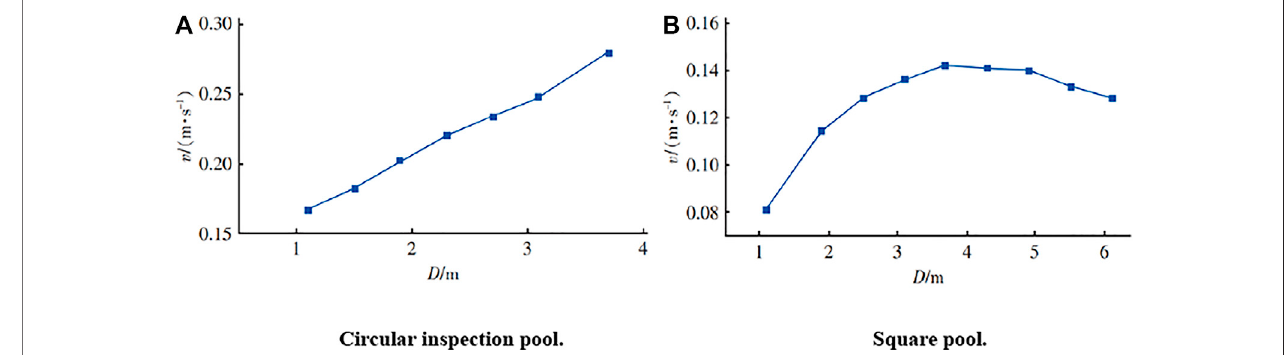
FIGURE 6 | Average fl ow velocity in two kinds of pools with different impeller diameters.